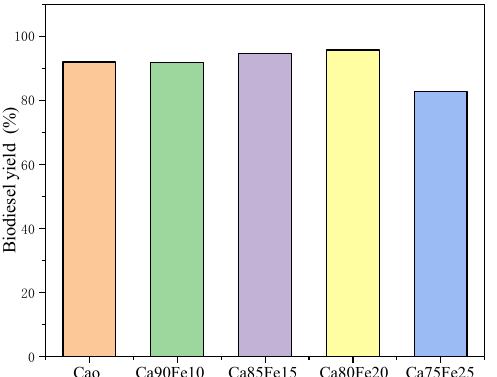
Figure 7. Comparison of the catalytic performance for pure Cao, Ca90Fe10, Ca85Fe15, Ca80Fe20 and Ca75Fe25 (reaction condition: catalyst dosage 11 wt. %, methanol: oil ratio of 9:1, 65 °C, 2 h).